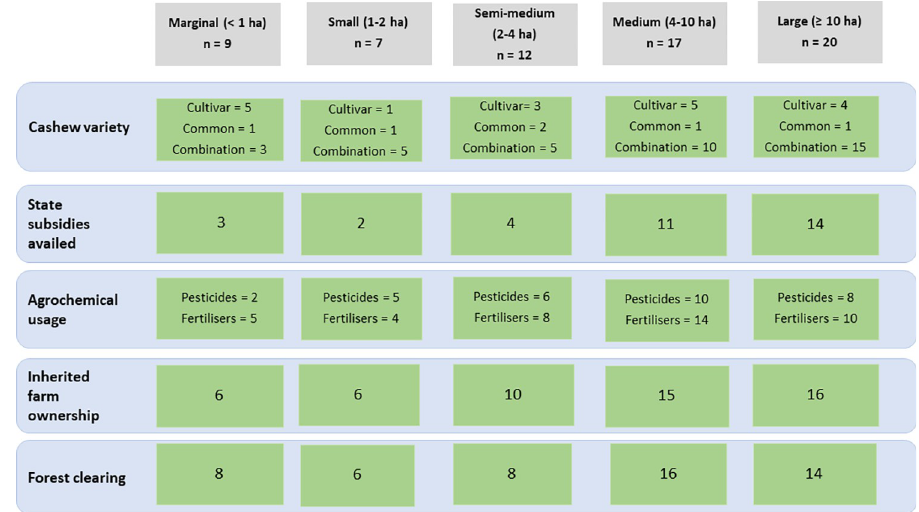
Fig 3. Typology of cashew farmers in Sawantwadi-Dodamarg landscape, South Maharashtra, India. The table shows the number of respondents (in green boxes) within each farmer category based on attributes (as shown in blue boxes). The category ‘cashew type’ refers to the number of farmers growing common, cultivar or a combination of the two. Similarly, the category ’agrochemical usage’ refers to the number of farmers using chemical pesticides and fertilizers in their farms. ‘State subsidies’, ‘Inherited farm ownership’ and ‘Forest clearing’ refer to the number of farmers that availed subsidies for the Government, inherited farmland from their family and cleared forest within the past 30 years for cashew cultivation, respectively. For detailed figures on all responses and no responses, please refer to S4 Table.